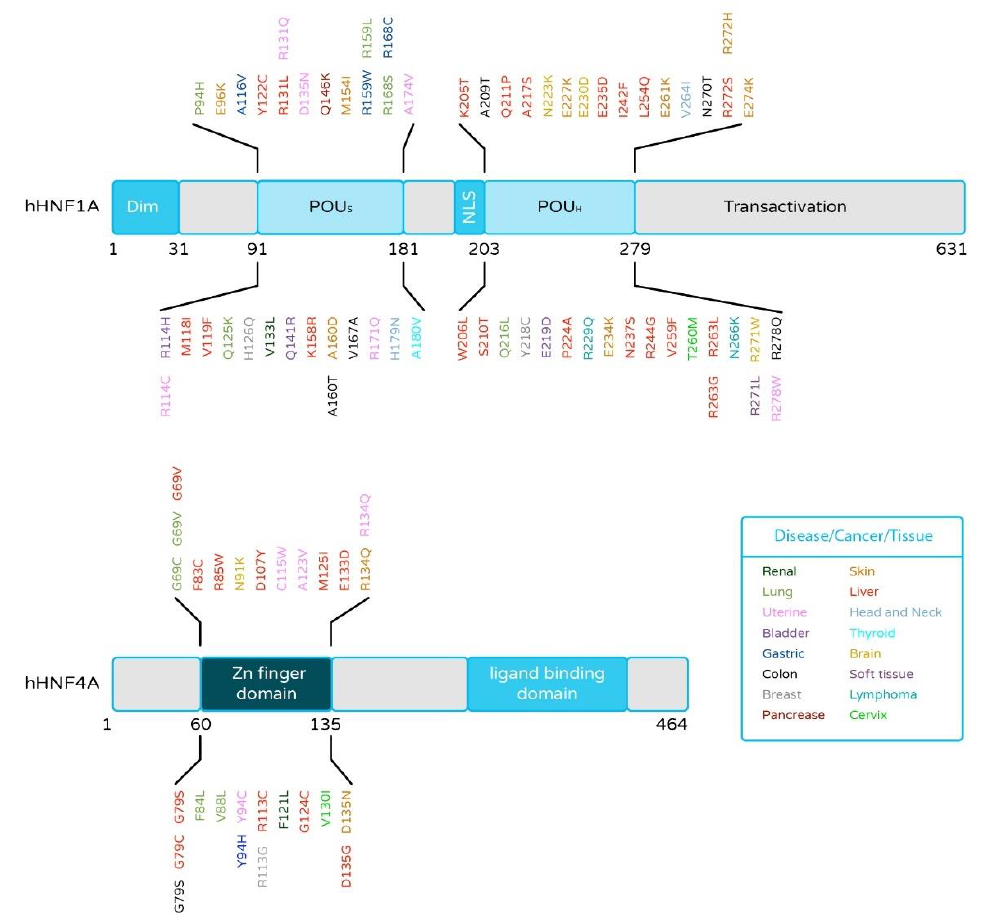
Figure 3. HNF1 α and HNF4 α mutations are found in their DNA-binding domain (DBD) in several cancers identified by the International Cancer Genome Consortium (ICGC). The amino acid positions of the identified mutations of HNF1 α and HNF4 α are shown, and the color coding indicates the type of cancer tissue in which the mutations were reported.